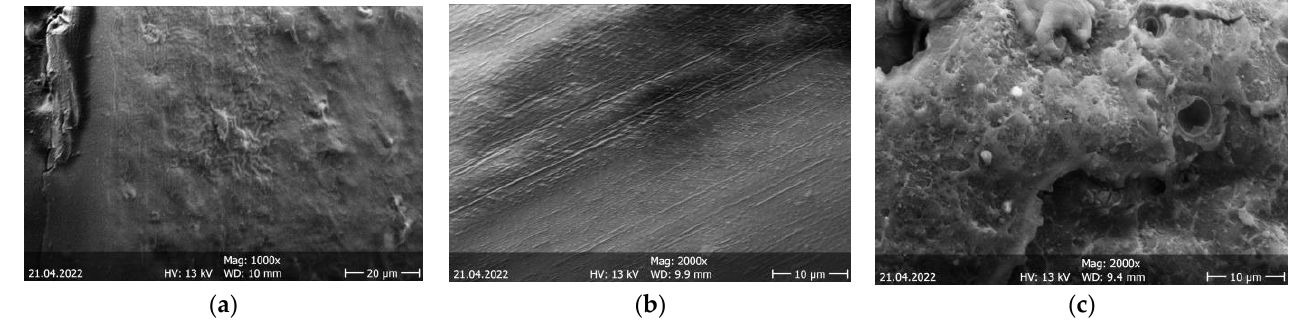
Figure 7. SEM images of 3D printed materials: ( a ) surface of PLA “UV”; ( b ) surface of PLA “temp”; ( c ) fractured surface of PLA “temp”. ( c ) fractured surface of PLA “temp”.